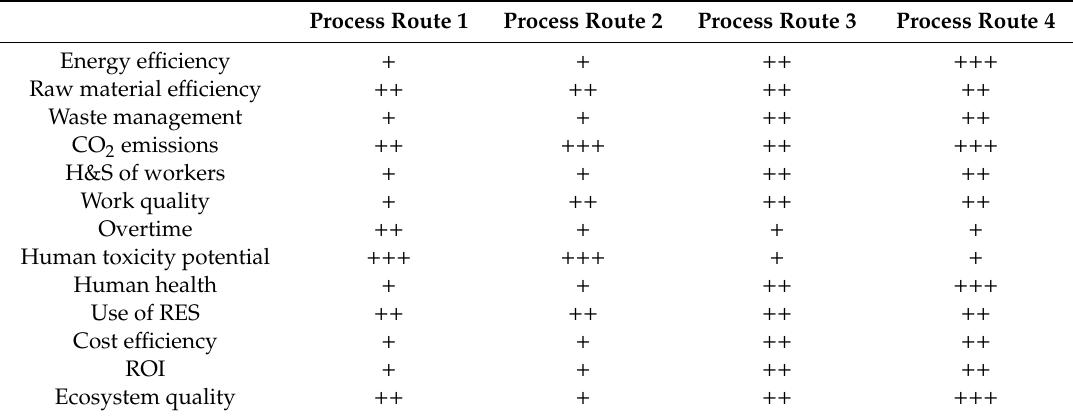
Table 2. Matrix for communicating alternatives (low